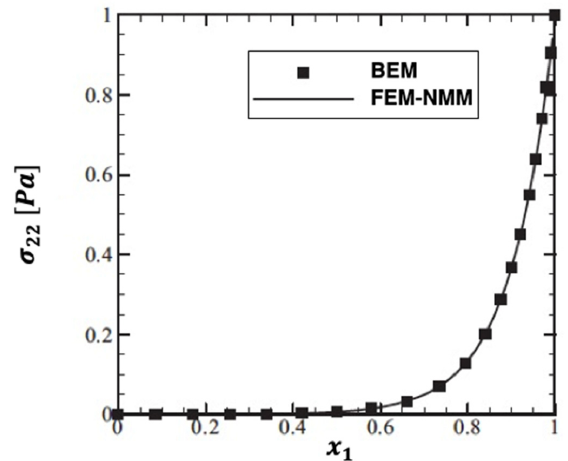
Figure 21. Variation of the thermal stress wave σ 12 along x 1 − axis in the special case of the functionally graded anisotropic fiber-reinforced plates for BEM and FEM-NMM.